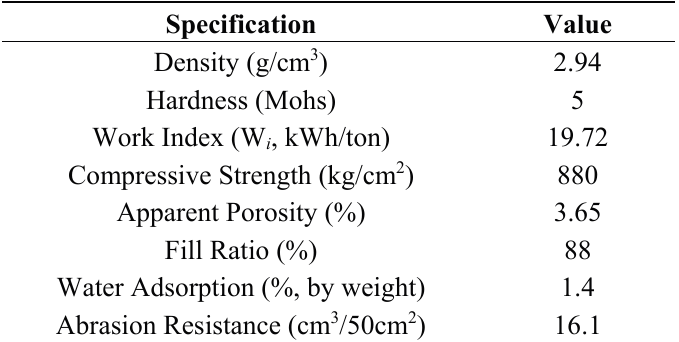
Table 1. Mechanical specifications of the basalt samples.